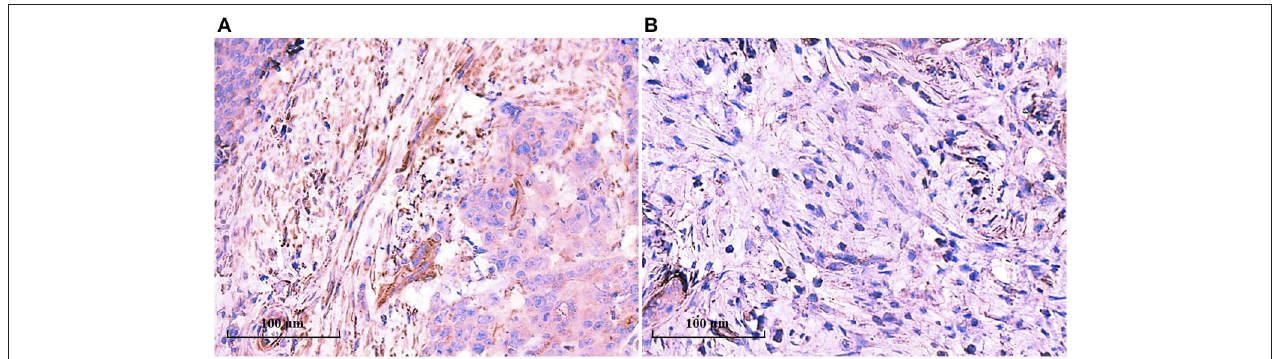
FIGURE 6 | IL-8 was highly expressed in mature CAFs. IL-8 expression in the tumor tissues was determined by IHC, and IL-8 was detected in tumor stroma rather than in tumor cells. IL-8 was highly expressed in mature CAFs (A) , while it was seldom detected in immature CAFs (B)